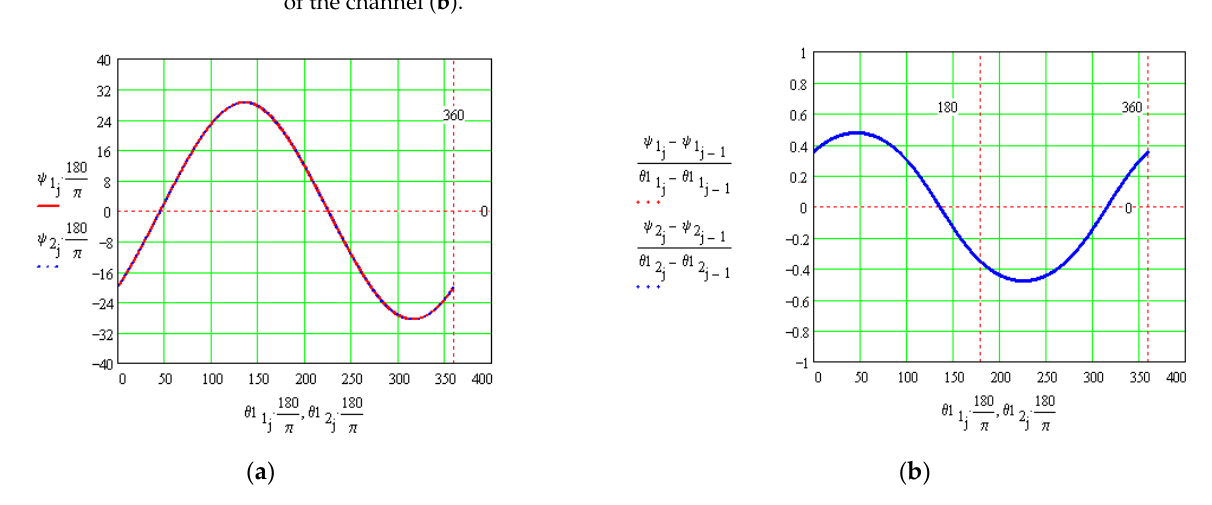
Figure 22. The angle of basculation ( a ) and the corresponding angular velocity ( b ) of the intermediate element with respect to the axis of centers.